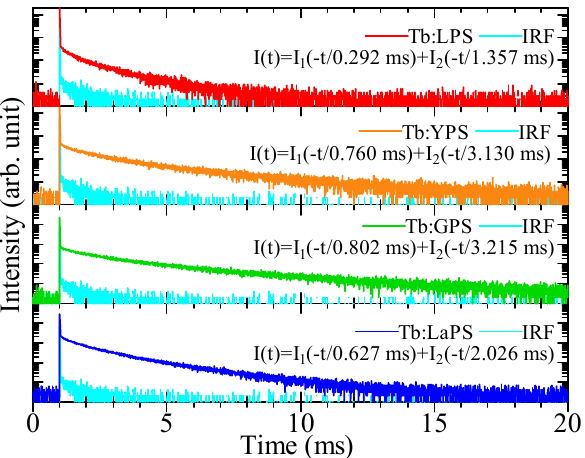
Figure 7. X-ray induced scintillation decay time of Tb-doped LPS, YPS, GPS, and LaPS samples.